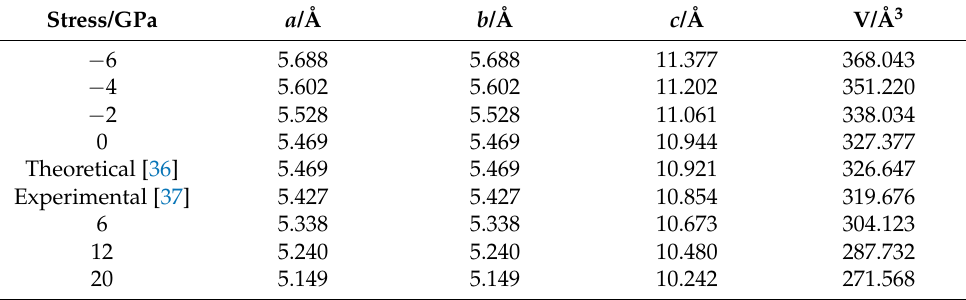
Table 1. Cu 2 ZnSnS 4 lattice constants of applied tensile and compressive